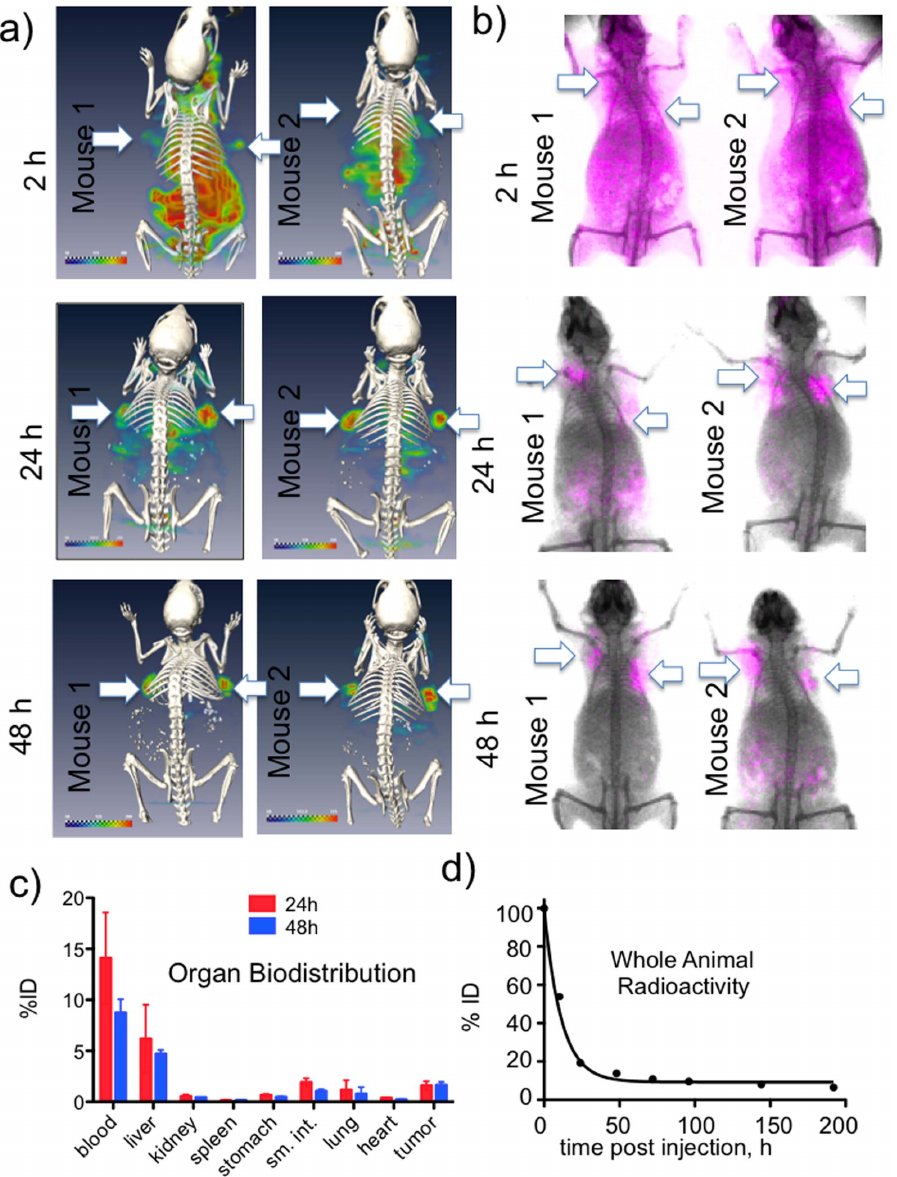
Figure 6. Multimodal imaging of EPR tumor targeting and elimination of PN(783)10.0. A ) SPECT/CT images of two mice bearing two HT- 29 tumors as a function of time after injection. At 2 h post injection, agent is in the blood and interstitium. By 24 h post-injection tumors are becoming apparent as agent is being cleared. At 48 h, labeling is highly tumor selective. B ) Surface fluorescence imaging of two additional mice bearing the same tumor. By surface fluorescence, as with SPECT, labeling is highly tumor selective at 48 h. C ) Organ biodistribution was obtained by dissection and 111 In counting at 24 h and 48 h post-injection. Data are means and standard deviations, n=5. D ) A whole animal radioactivity elimination curve. Data are means and standard deviations, with extremely small standard deviations,